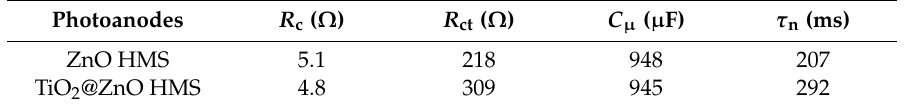
Figure 9. Nyquist plots of EIS spectra of QDSSCs recorded under dark at an applied bias of − 0.5 V, the inset shows the equivalent circuit of our device. Table 2. Fitting results of EIS of QDSSCs based on ZnO HMS and TiO 2 @ZnO HMS photoanodes .